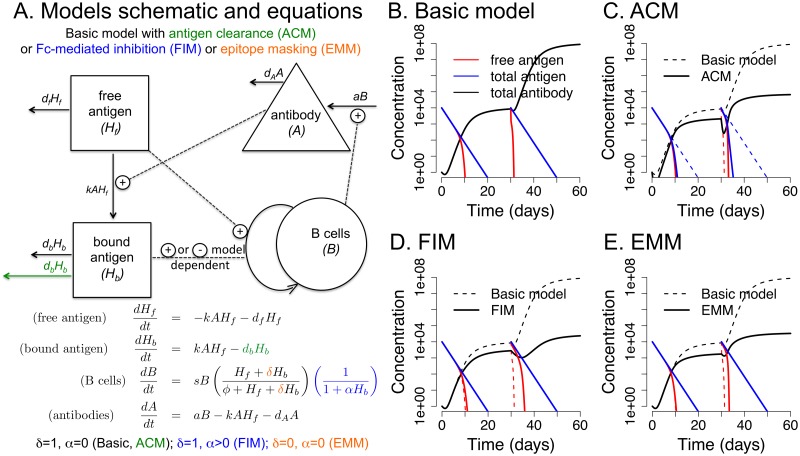
Dynamics of the immune response during primary and booster immunizations in the one-epitope model.Panel A shows a schematic and the equations for the basic one-epitope model with addition of enhanced antibody-bound antigen clearance (in green), FcγR-mediated inhibition (in blue), or epitope masking (in orange). Panels B-E show the dynamics of antigen and immune responses following primary and secondary immunization in these models. Panel B shows that in the basic model primary and secondary immunizations result in identical boosts (fold increases in antibody). Panels C, D and E show that in the ACM, FIM and EMM, respectively, the antibody generated during the primary response reduces the boosting of antibody following the second immunization. Parameters are shown in Table 1, d
b = 3 for the ACM, α = 0 for basic, ACM, EMM and α = 0.01 for FIM.